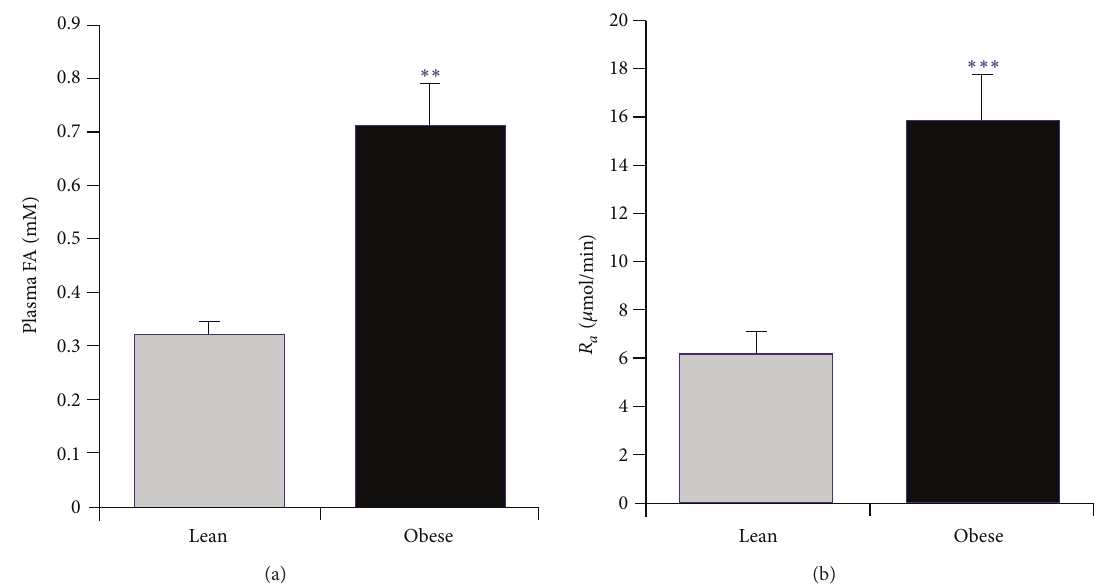
Figure 1: Whole-body FA metabolism in lean (Lean) and obese (Obese) Zucker rats. 𝑅 𝑎 plasma FA appearance rate. Results are expressed as